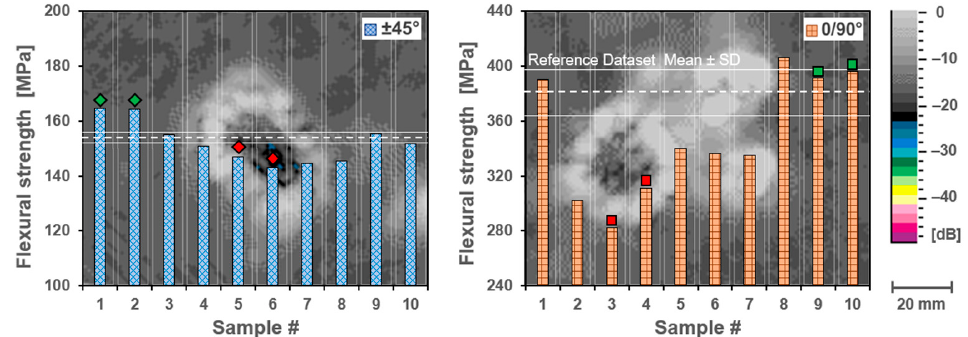
Figure 6. Flexural strength determined in three-point bending test in comparison to the C-scan image. The flexural strength mean value (dashed white line) of the reference samples with associated standard deviation (thin white line). Samples with variation in local damping show a decrease in flexural strength.